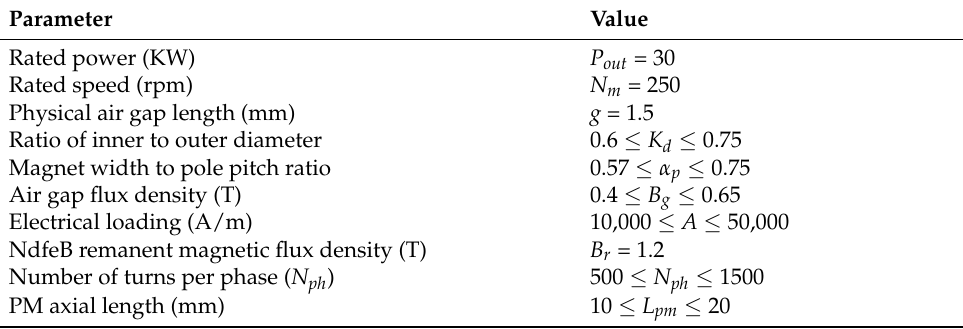
Table 4. Design constraints and requirements of the ironless AFPMWG.